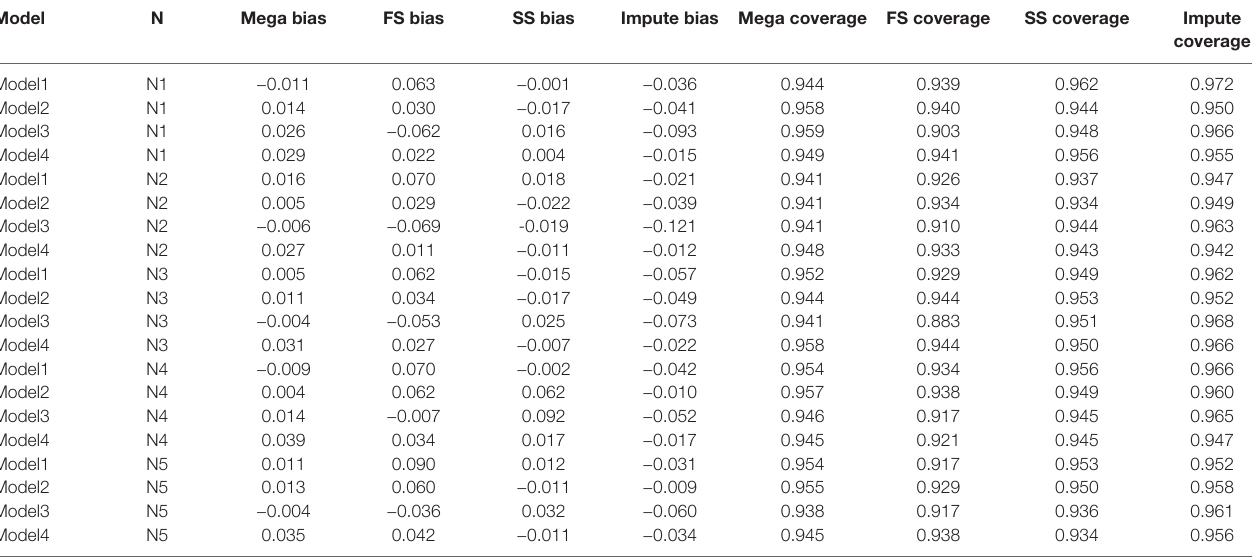
FS, factor score meta-analysis; Mega, BFIM SEM mega-analysis; SS, mean score meta-analysis; Impute, multiple imputation.